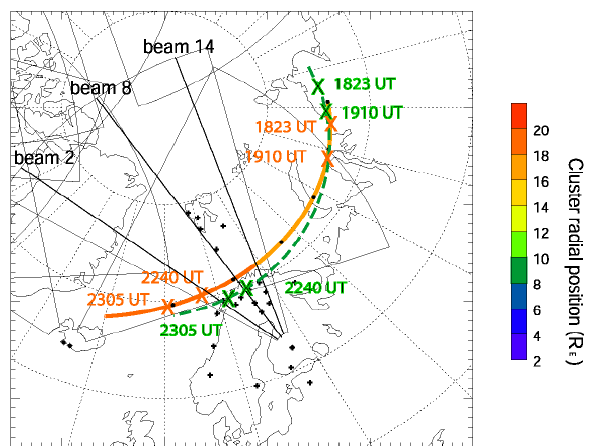
Fig. 1. Cluster 1 (Rumba) footprint (solid orange line) and Polar footprint (dashed green line) mapped on to SuperDARN fields-of- view, with IMAGE magnetometer stations (black crosses). Times of interest are marked with orange crosses for the Cluster footprint and green crosses for the Polar